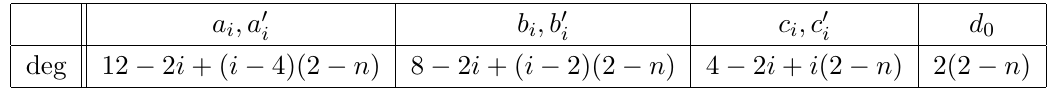
Table 5 . The \coe(cid:14)cients" a i , b i , etc. in (3.78) are sections of O P 1 (deg), with the degree \deg" speci(cid:12)ed in this